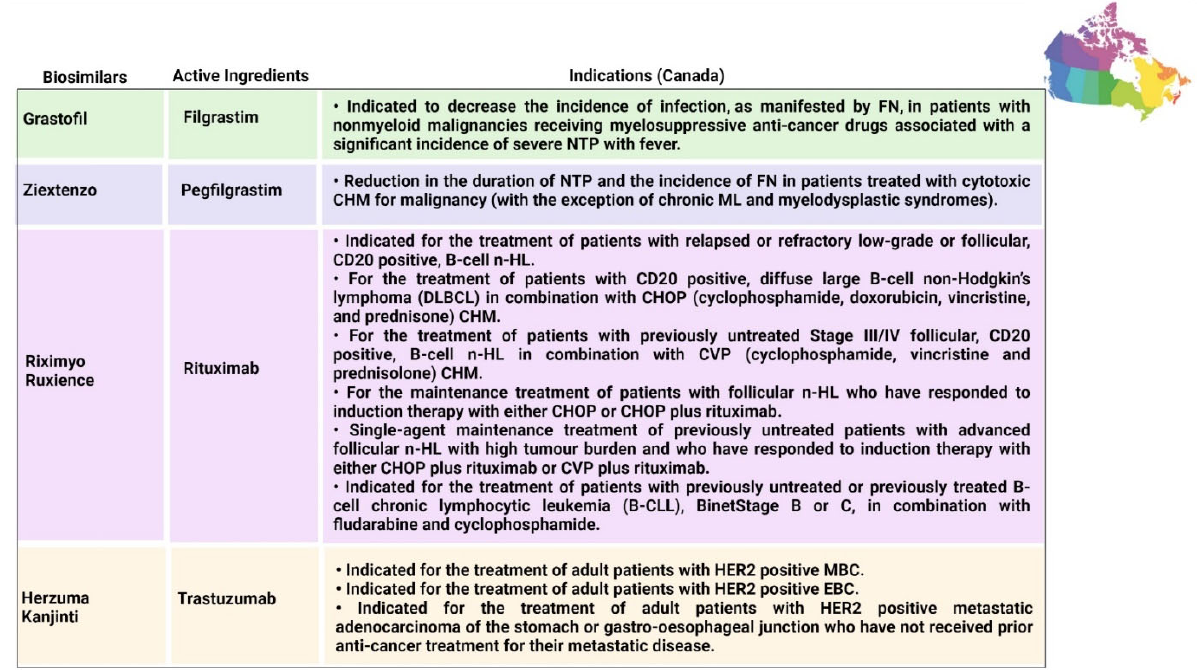
Figure 8. Indications approved in Canada for biosimilars [132,133,134,135,136,137]. B ‐ CLL = B ‐ cell chronic lymphocytic leukemia; CD20 = cluster of differentiation 20; CHM = chemotherapy; CHOP = cyclophosphamide, doxorubicin hydrochloride (hydroxydaunorubicin), vincristine sulfate (Oncovin), and prednisone; CVP = cyclophosphamide, vincristine, and prednisone; DLBCL = diffuse large B ‐ cell non ‐ Hodgkin lymphoma; EBC = early breast cancer; FN = febrile neutropenia; HER2 = human epidermal growth factor receptor 2; MBC = metastatic breast cancer; ML = myeloid leukemia; n ‐ HL = non ‐ Hodgkin lymphoma; NTP = neutropenia; PBPC = peripheral blood progenitor cell. 7. Regulatory Guidelines Associated with Biosimilars Globally The rules and regulations of biosimilars are improving globally, particularly in the USA and Europe, in order to attain harmonization all over the world. There are a few main regulatory authorities, such as the EMA, FDA, and WHO, which have set up standards to determine the similarity between the reference products and biosimilars. Many regulatory agencies require comparative studies to evaluate the safety, quality, and efficacy of biosimilars in oncology. In comparison to the small ‐ molecule drugs, biosimilars are more complex in nature, which makes them more subtle. The first regulatory authority to provide a framework for biosimilars was the EMA back in 2003, whereas the primary approval for such products was given in 2006. In 2009, the FDA standardized the specific guidelines for the approval of biosimilars [138]. Moreover, since 2008 and 2012, many other countries—such as Canada, Japan, India, South Korea, and Australia—have also produced their own guidelines, which are analogous to the EMA guidelines. Recently, China and Russia have been setting up standardized regulatory pathways; however, they have been approving biosimilars as new biologics thus far [139]. Furthermore, there are many developing countries that do not have regulatory pathways for biosimilars, so they allow extrapolation to indications that have been approved previously. The various existing regulatory procedures across the world are discussed below. 7.1. Europe According to the EMA guidelines, there is a streamlined approval process available for biosimilars that is based on preclinical and clinical studies that compare their efficacy, safety, and immunogenicity with the reference biological products [140]. There must be a